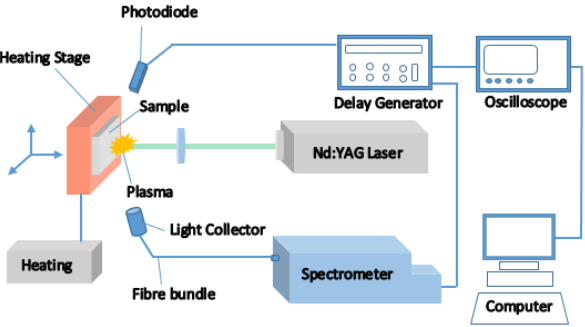
Figure 2. Schematic diagram of the setup used for the target heating of the